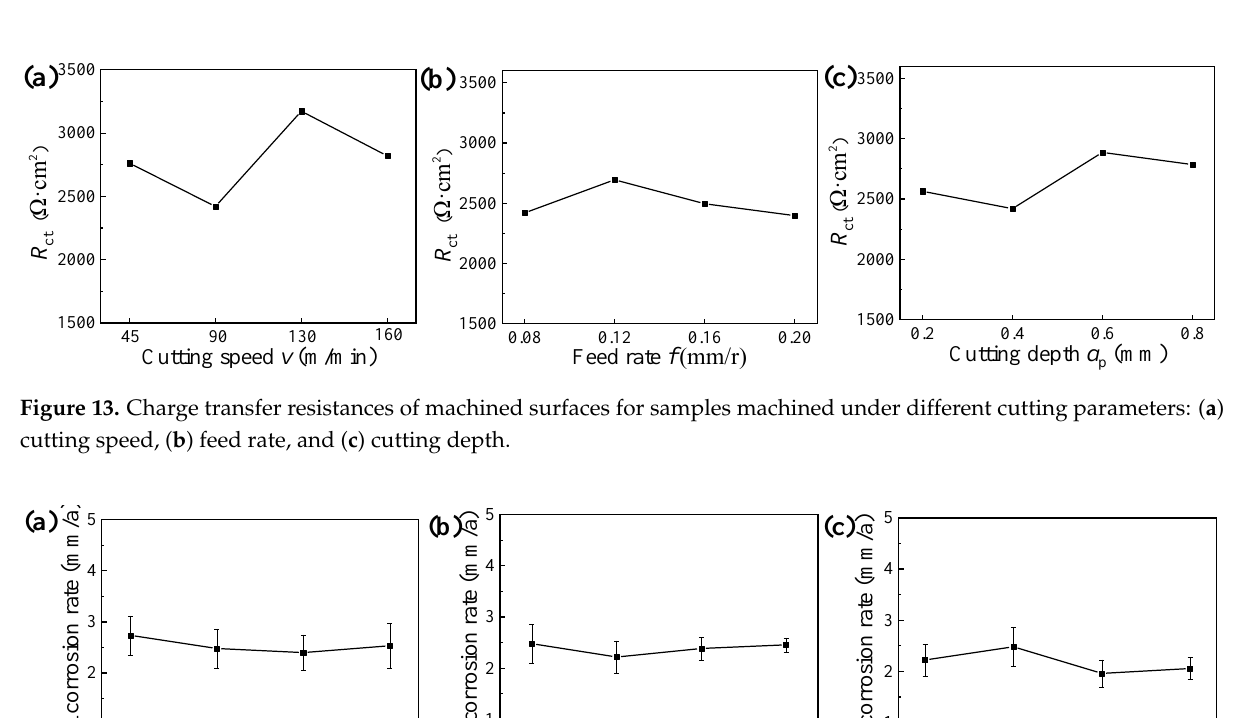
Figure 12. Nyquist plots and Bode plots of machined surfaces for samples machined under different cutting parameters: (a) cutting speed, (b) feed rate, and (c) cutting depth; and ( d ) equivalent circuit model of electrochemical impedance.